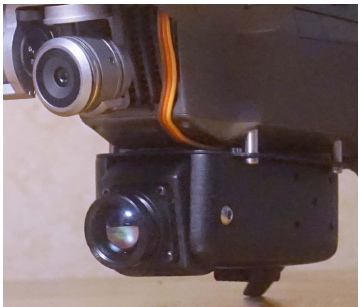
Figure 4. Color and thermal cameras installed on DJI Mavic quadcopter.